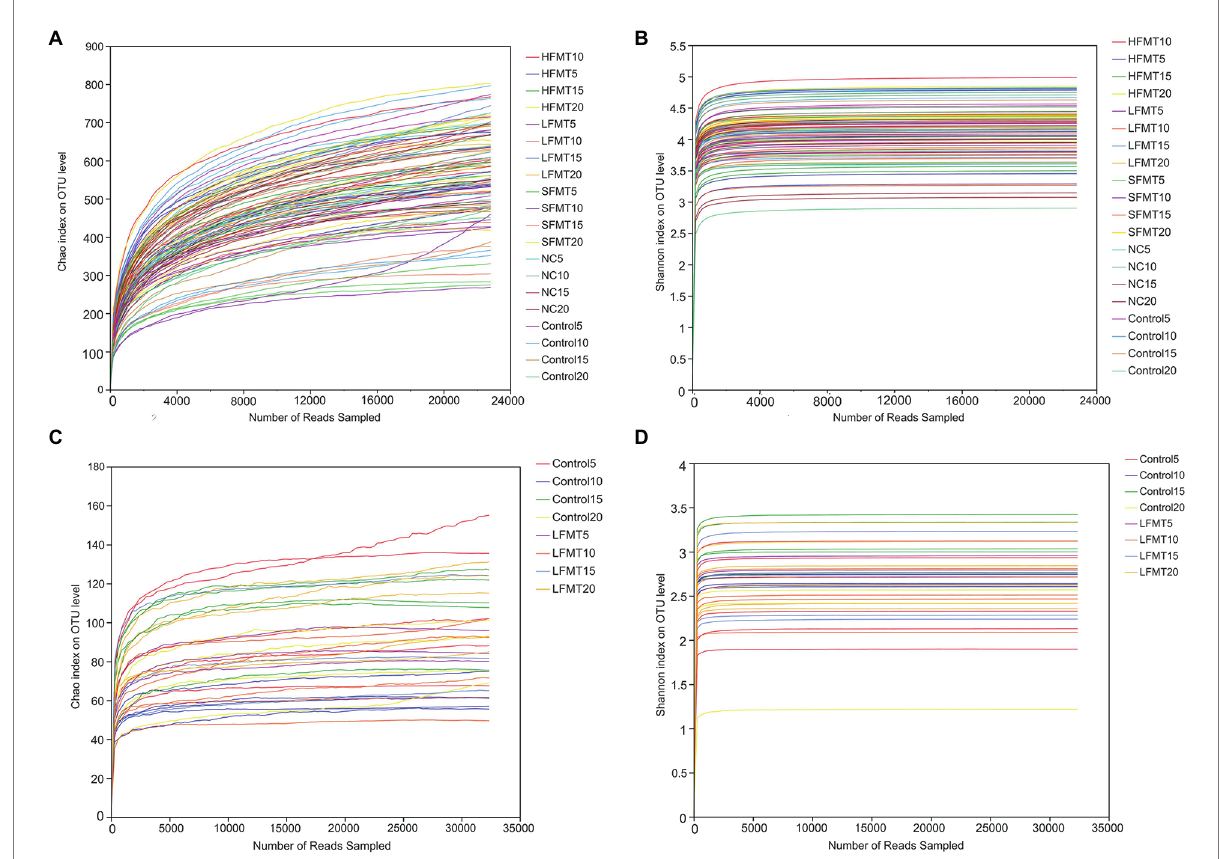
FIGURE 2 Sparsity curve analysis of stool samples. (A) Bacterial dilution curve based on Chao index. (B) Bacterial dilution curve based on Shannon index. (C) Fungal dilution curve based on Chao index. (D) Fungal dilution curve based on Shannon index. The x-axis represents the amount of randomly sampled sequencing data; the y-axis represents the number or diversity index of observed species. Each curve shown in the graph with a different color represents a